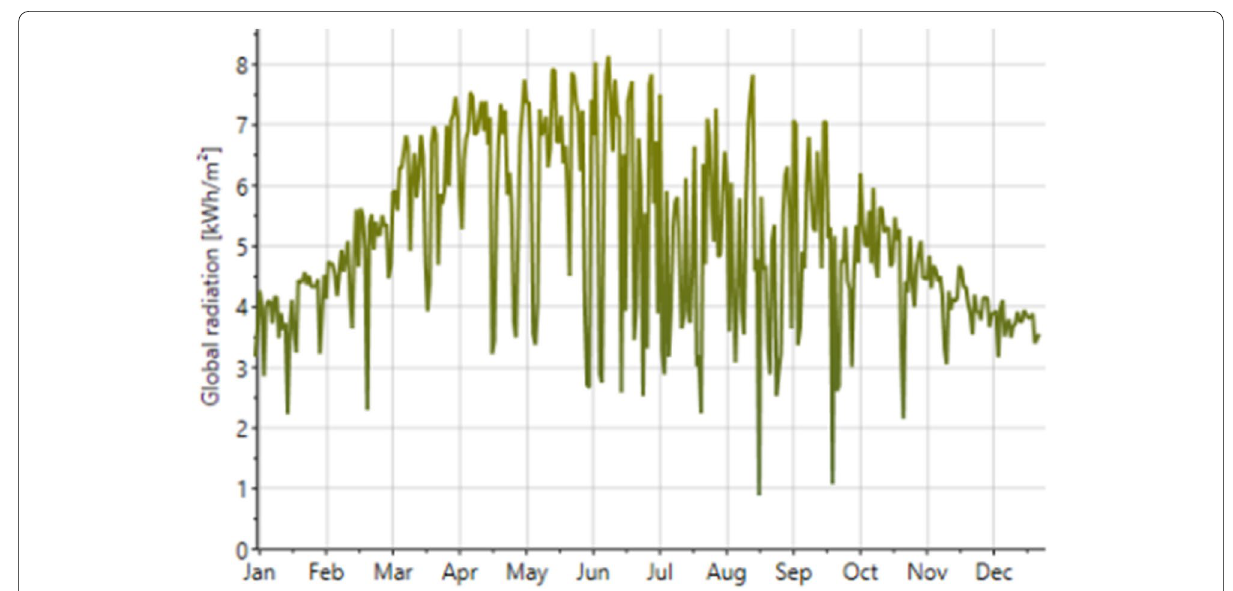
Fig. 3 Daily global radiation at the selected location in